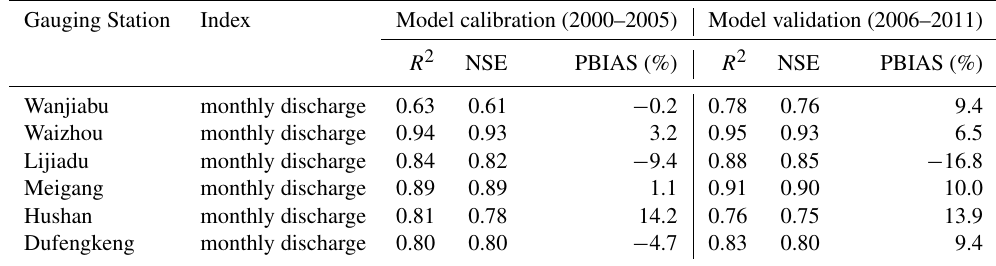
Table 3. Quantitative assessment of calibration and validation for SWAT model.